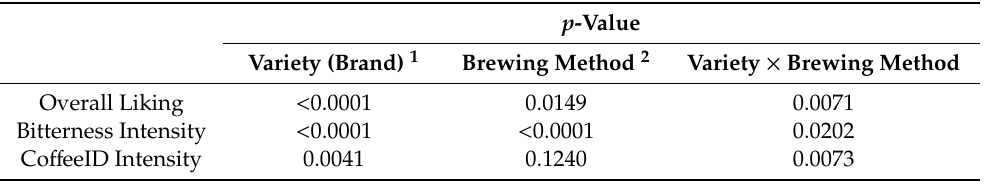
Table 7. p -Values of co ff ee variety (brand) and brewing method e ff ects for consumers’ overall liking, bitterness intensity, and co ff eeID intensity of CB and CM samples.